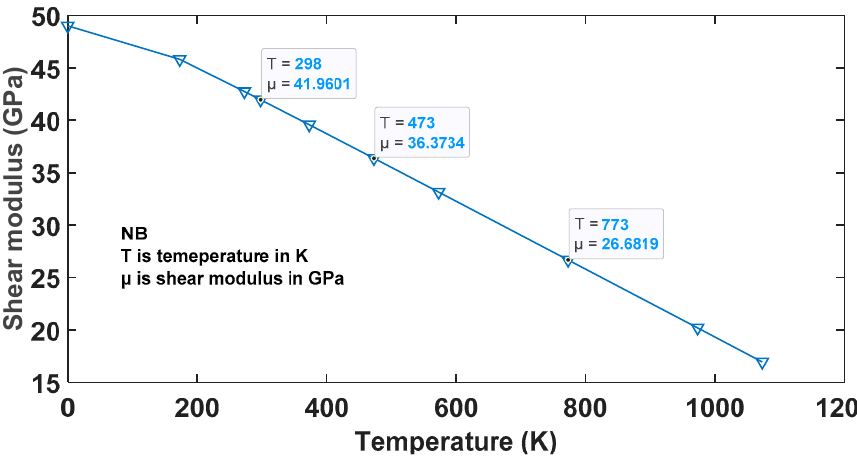
Figure 4. The shear modulus of Ti6Al4V(ELI) as a function of absolute